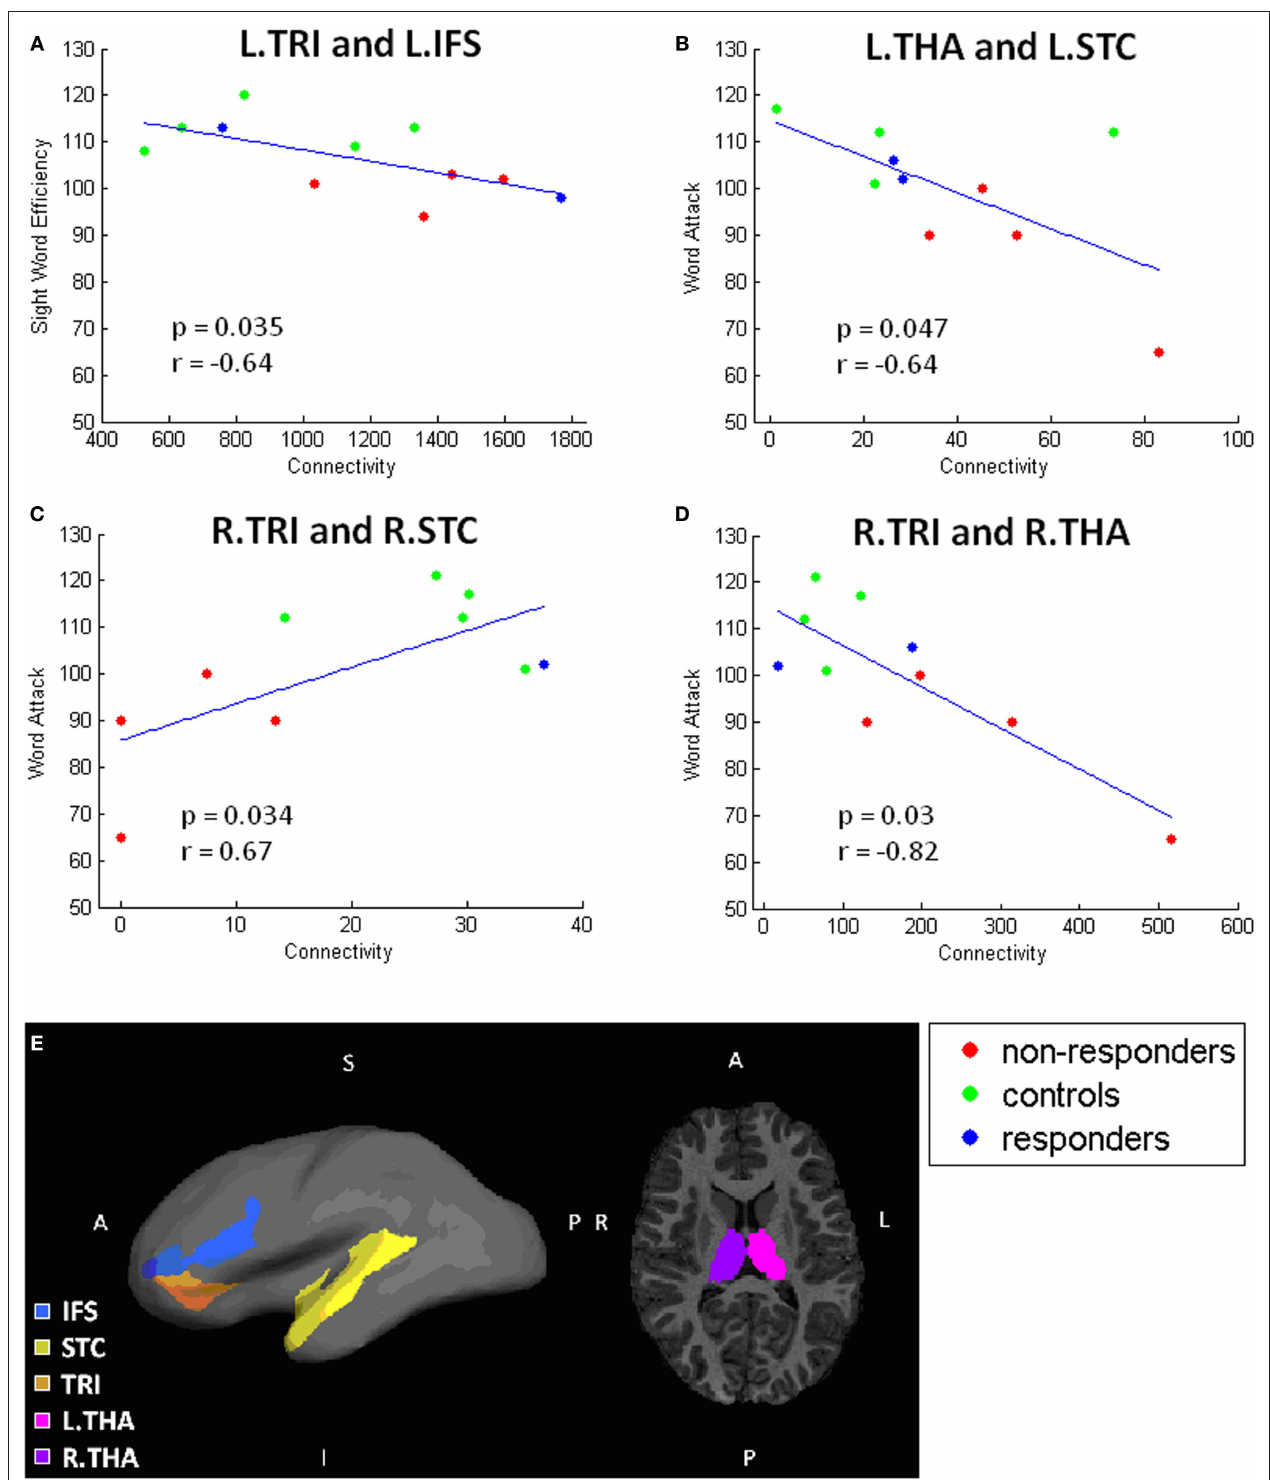
FiguRe 6 | Remaining significant correlations. Scatterplots showing correlations between connectivity and behavioral test performance. Each scatterplot corresponds to one pair of gray matter regions: (A) L.TRI and L.IFS, (B) L.THA and L.STC, (C) R.STC and R.TRI, (D) R.THA and R.TRI. Locations of these regions are illustrated in (e)